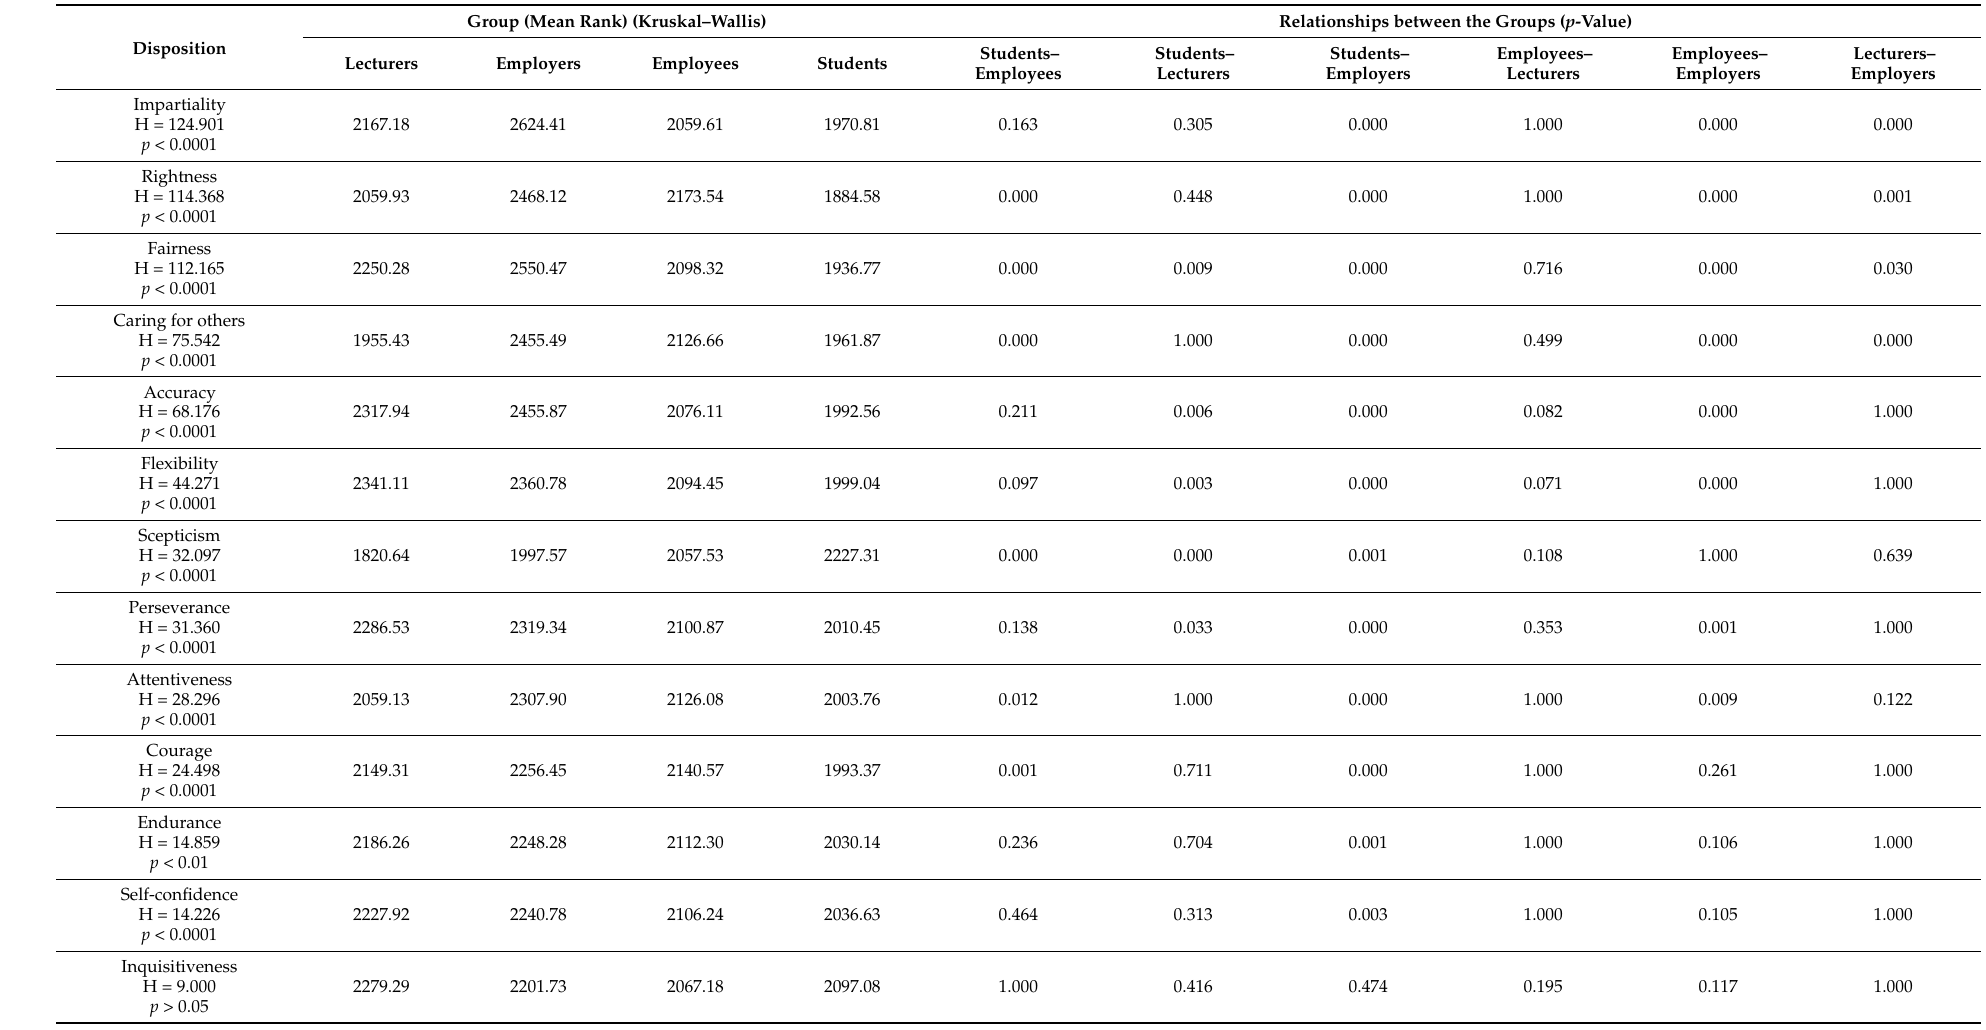
Table 8. Comparison by group of evaluation of the importance of critical thinking dispositions in the modern labour